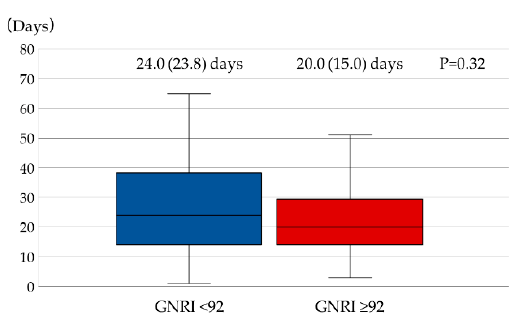
Figure 2. Comparison of length of hospital stay between patients with GNRI < 92 and ≥ 92 in HFrEF. There was no significant difference in the length of hospital stay between patients with GNRI < 92 and ≥ 92. Mann–Whitney U-test was used for comparison between the two groups. Abbreviations: GNRI, Geriatric Nutritional Risk Index; HFrEF, heart failure with reduced ejection fraction Table 3. Univariate and multivariate analyses of factors associated with length of hospital stay in HFrEF. Table 4. Characteristics of patients with HFpEF. Total ( n = 250)